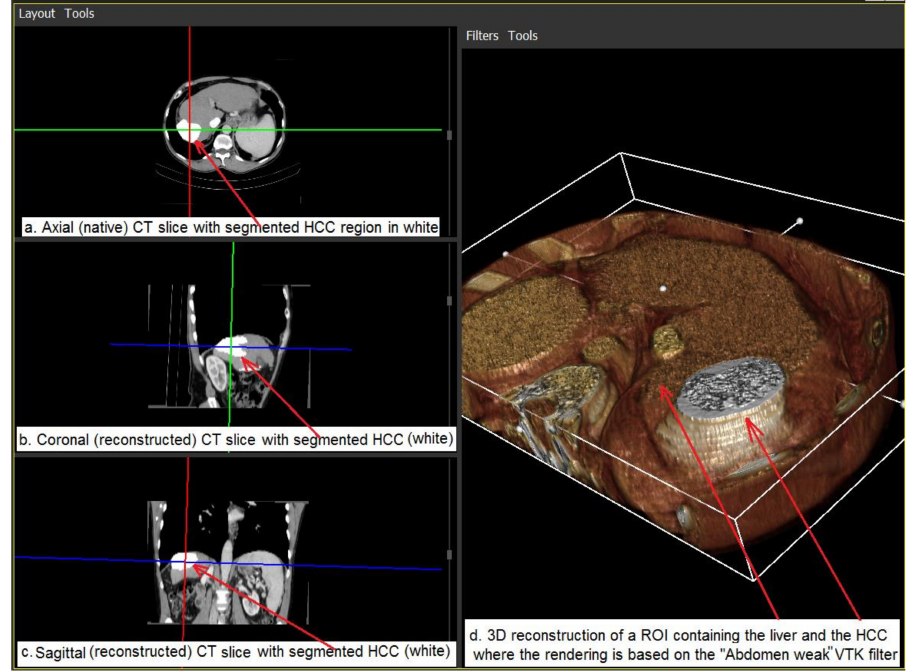
Figure 5. The 3D model of the HCC tumor within the liver (right); the corresponding axial, coronal and sagittal slices with the depicted HCC tumor emphasized